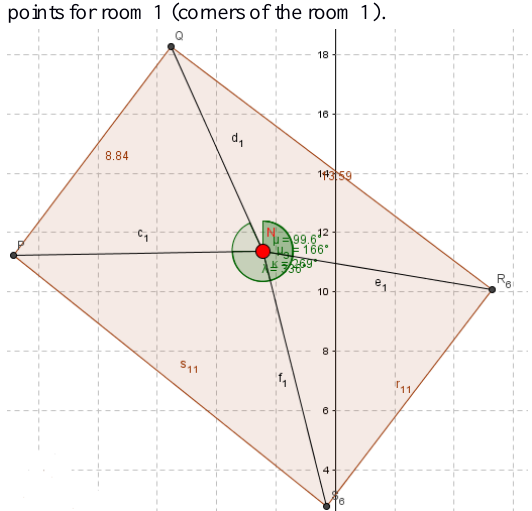
Figure 2: Room 1, where the red point represents the position of the rangefinder and black points represent measured corners.